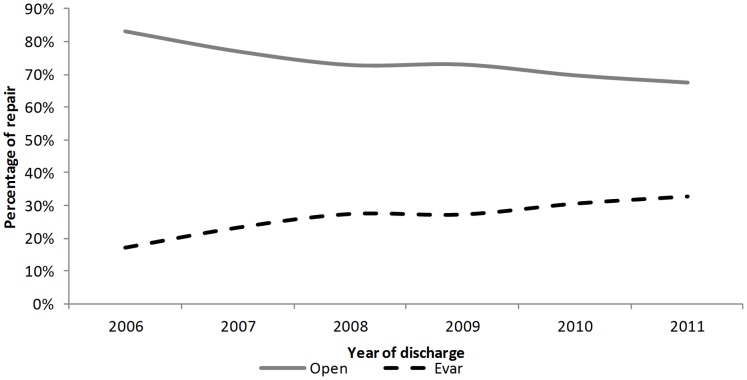
Percentage of OSR/EVAR in rAAAs.